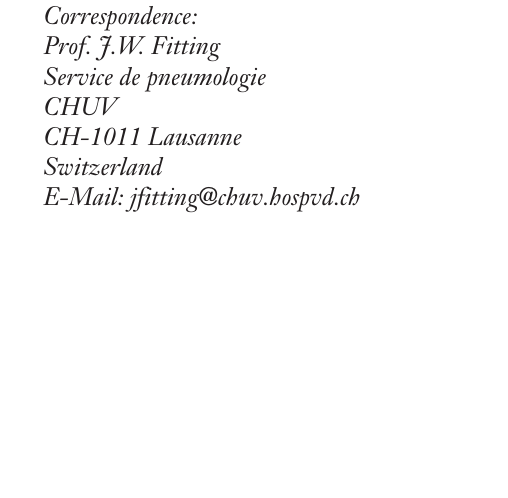
Table 1 Common abnormal patterns of carbon monoxide transfer